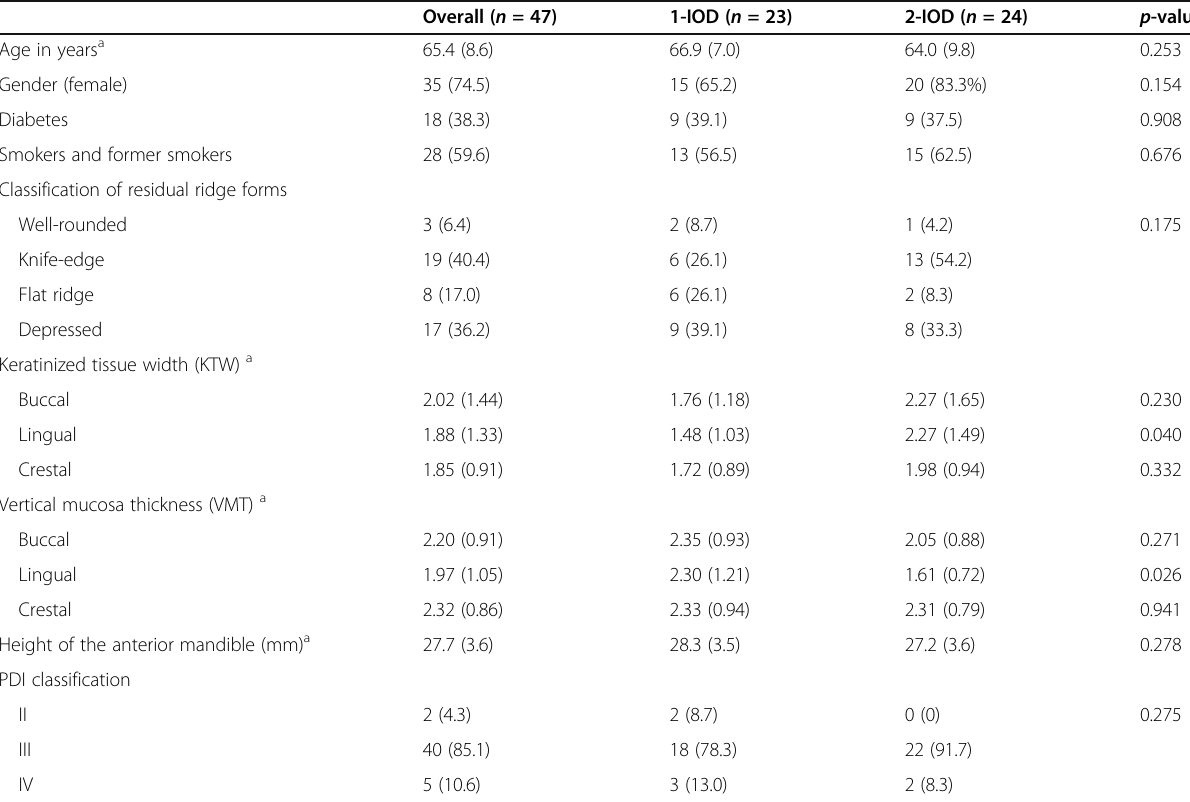
Table 1 Frequency distributions and comparisons of baseline patient characteristics and local clinical features of the study